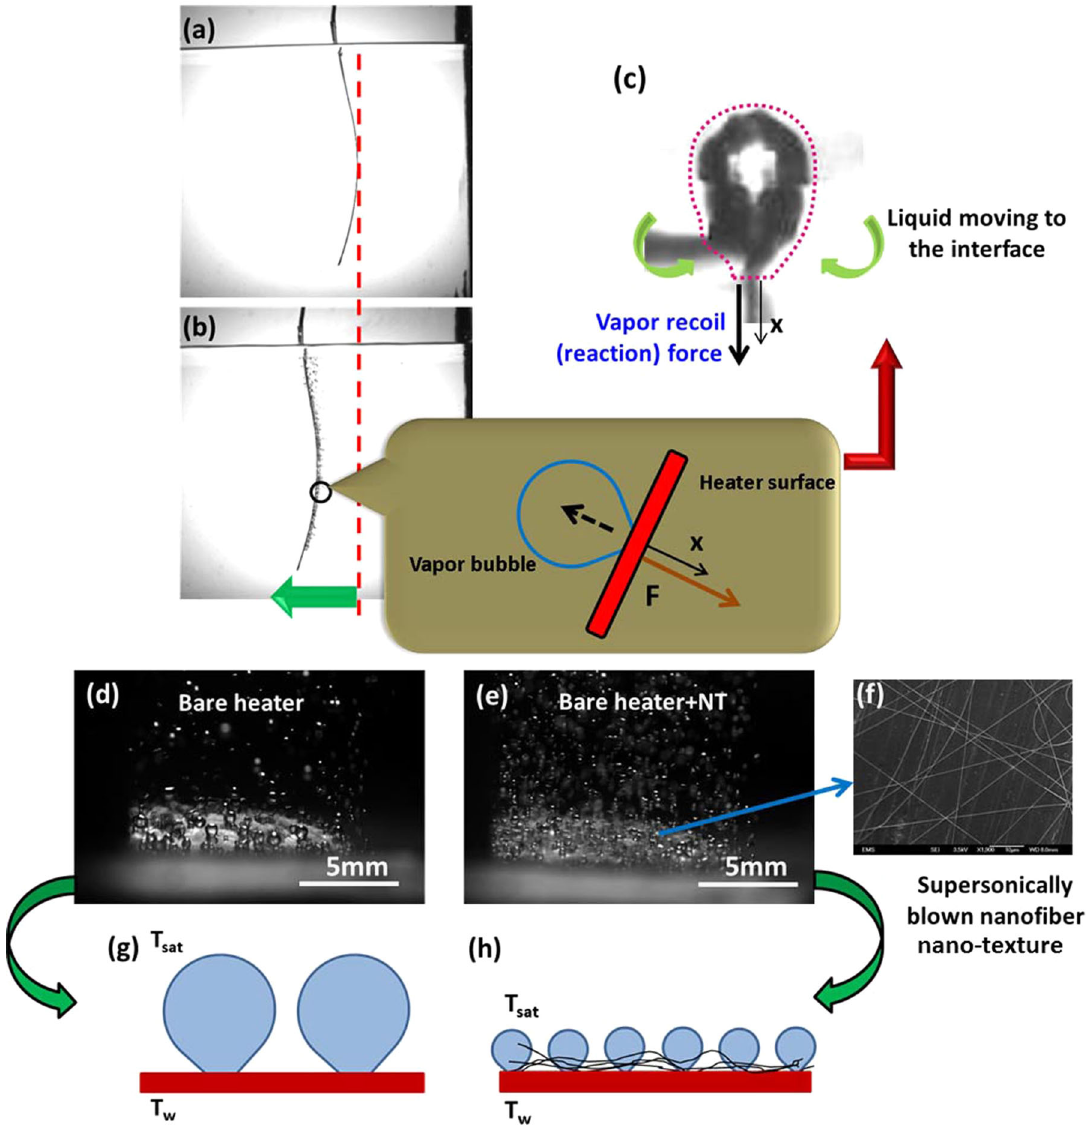
Fig. 1 a Single Bare heater prior to boiling. b The heater displacement from the baseline ( red dashed line ) in 22 s after the inception of boiling. The inset shows a zoomed-in sketch of a single vapor bubble departing from the surface and the vapor recoil force shown by the bold arrow. c Photograph of a vapor bubble prior to the detachment with the boundary of the control volume surrounding its free surface and encompassing the heater surface under its footprint shown by the dashed red line . d Boiling on the Bare surface. e Boiling on the Bare+NT surface. f SEM image of Bare+NT surface. g and h Sketches of the characteristic sizes of vapor bubbles on the corresponding